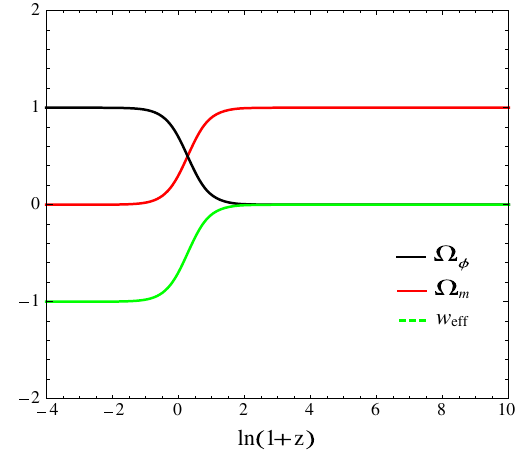
Fig. 1 The time evolution of the relative matter energy density Ω m , the relative scalar field energy density Ω φ and the effective EoS w